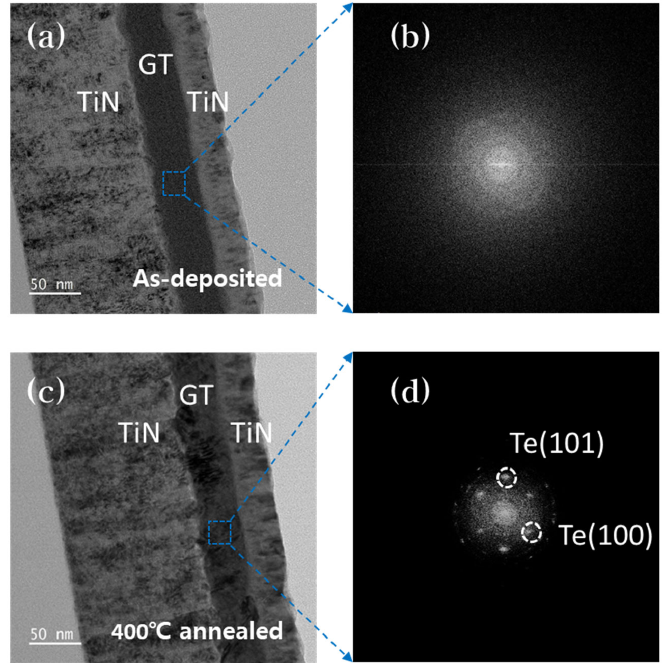
Figure 5. ( a , c ) are cross ‐ sectional view before and after annealing GT with TiN/GT/TiN structures obtained by high ‐ resolution transmission electron microscope (HR ‐ TEM) analysis for direct observation of GT thin films. ( b , d ) show the FFT results of ( a , c ) layers.